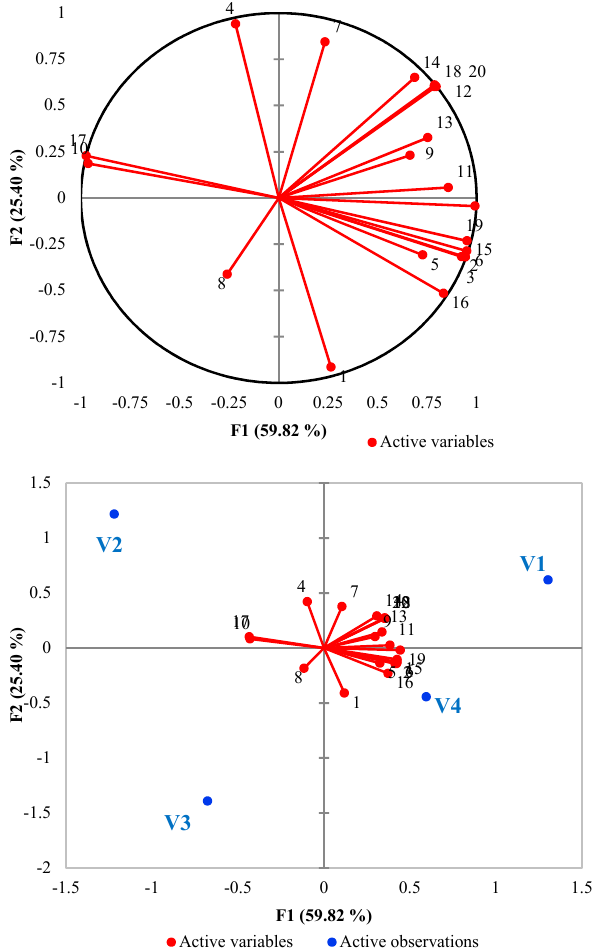
Figure 1. Principal component analysis based on the gas-chromatograph results: 1 , Isoamyl acetate; 2 , Ethyl octanoate; 3 , Ethyl decanoate; 4 , Diethyl succinate; 5 , 2-Phenethyl acetate; 6 , Ethyl laurate; 7 , Isopropyl myristate; 8 , Ethyl palmitate; 9 , Ethyl oleate; 10 , Butyric acid; 11 , Hexanoic acid; 12 , Octanoic acid; 13 , Decanoic acid; 14 , 9-Decenoic acid; 15 , Isoamyl al- cohol; 16 , 4-Octanol; 17 , 1-Heptanol; 18 , Phenylethyl alcohol; 19 , Linalool L; 20 , α -terpineol; V1—FIZZ ™ , V2—IOC DI- VINE ™ , V3—LEVULIA CRISTAL ™ , V4—IOC 18-2007 ™.